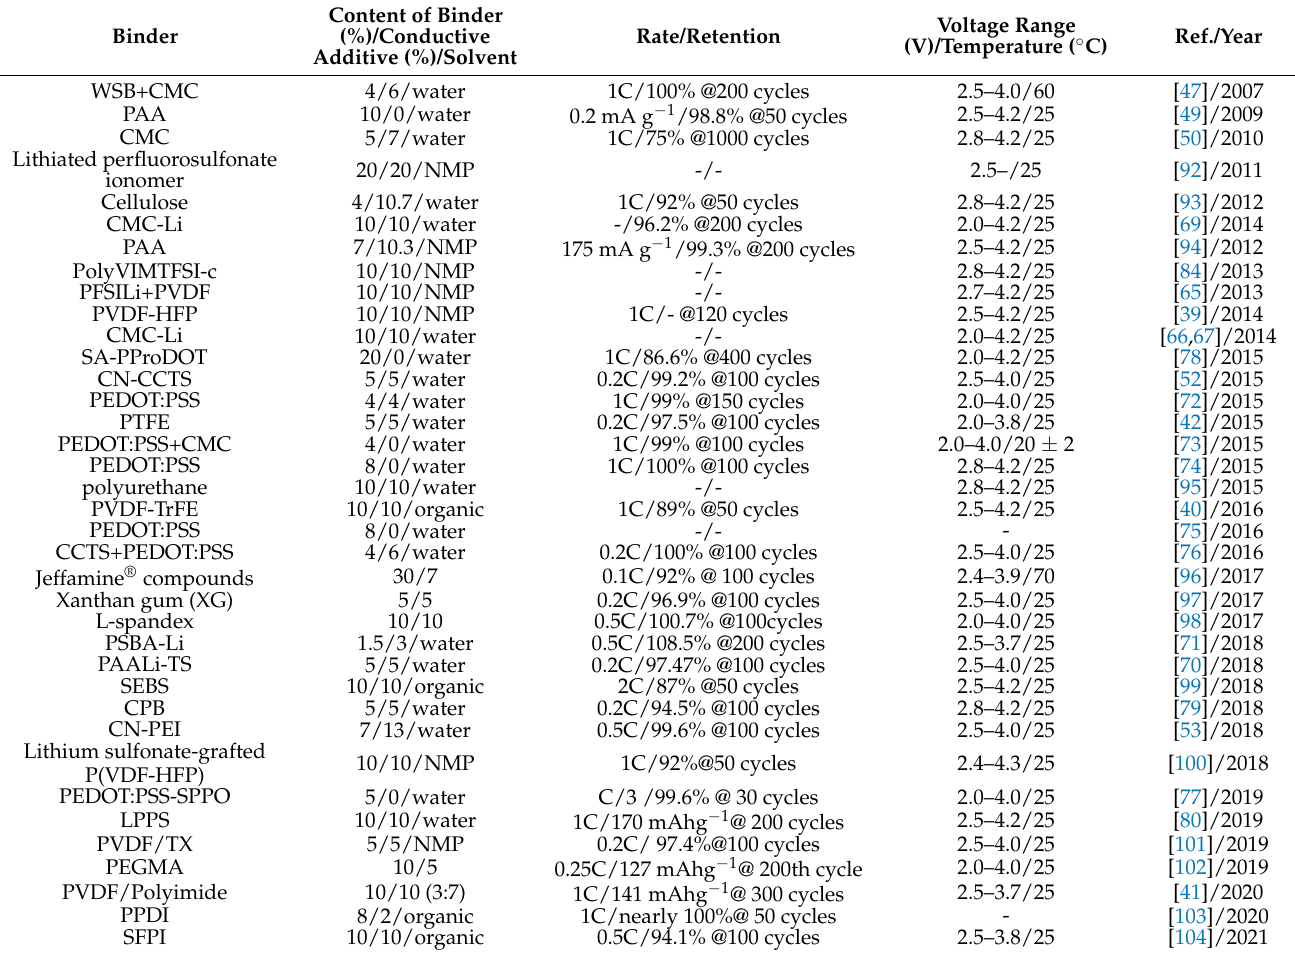
Table 1. Summary of the main studies related to LiFePO 4 cathodes obtained using various polymer